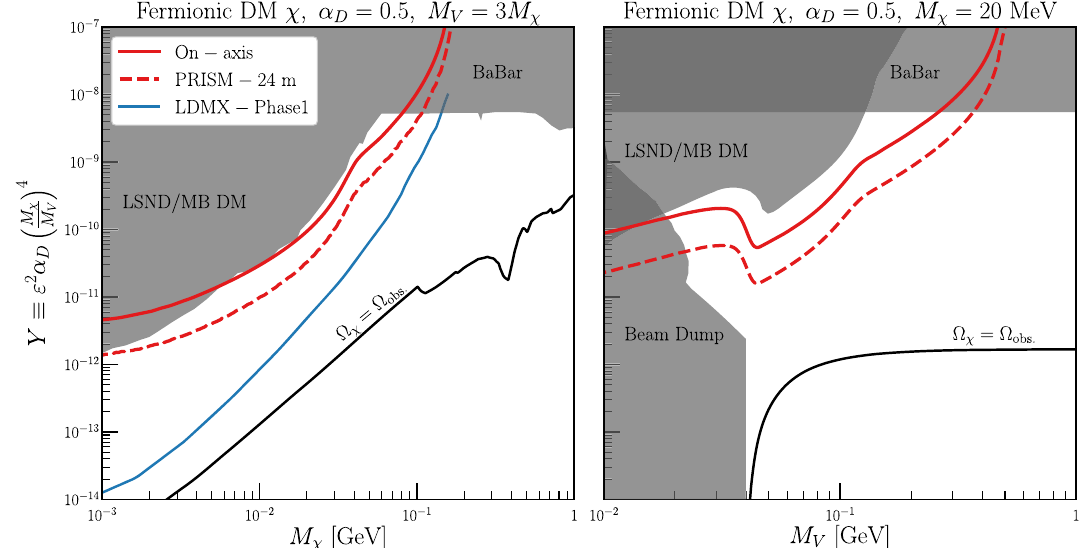
Fig. 19 Expected DUNE On-axis (solid red) and PRISM (dashed red) sensitivity using χ e − → χ e − scattering. We assume α D = 0 . 5 in both panels, and M V = 3 M χ ( M χ = 20MeV) in the left (right) panel,